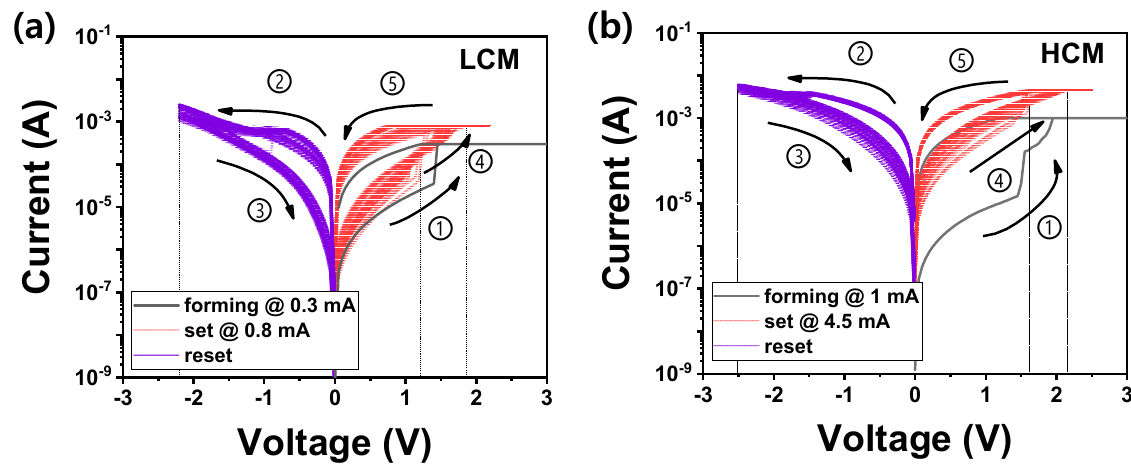
Figure 2. I − V curves of ITO/ZnO/TaON/TaN RRAM in ( a ) LCM and ( b ) HCM. Black lines indicate forming process, purple lines indicate reset process, and red lines indicate set process. The one cycle switching follows the order of the numbers ( ① → ⑤ ).